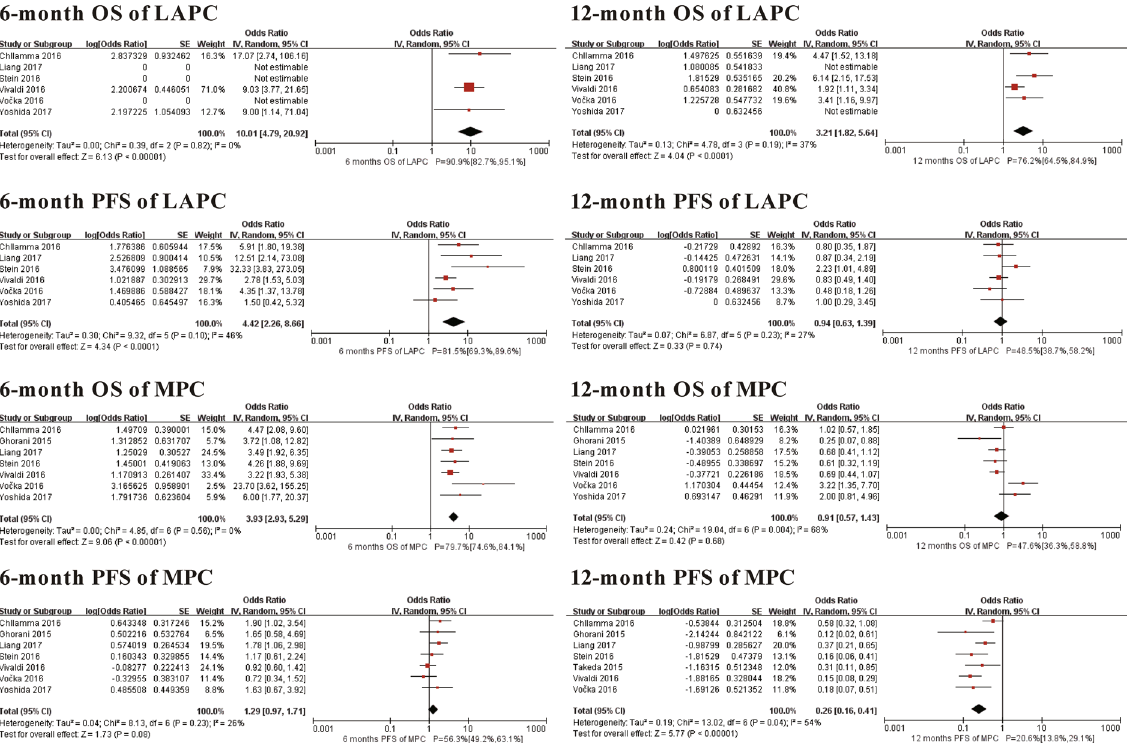
Figure 2. Meta-analysis for survival date. SE: standard error. IV: random-model generic inverse variance method. 95% CI: 95% confidence interval.